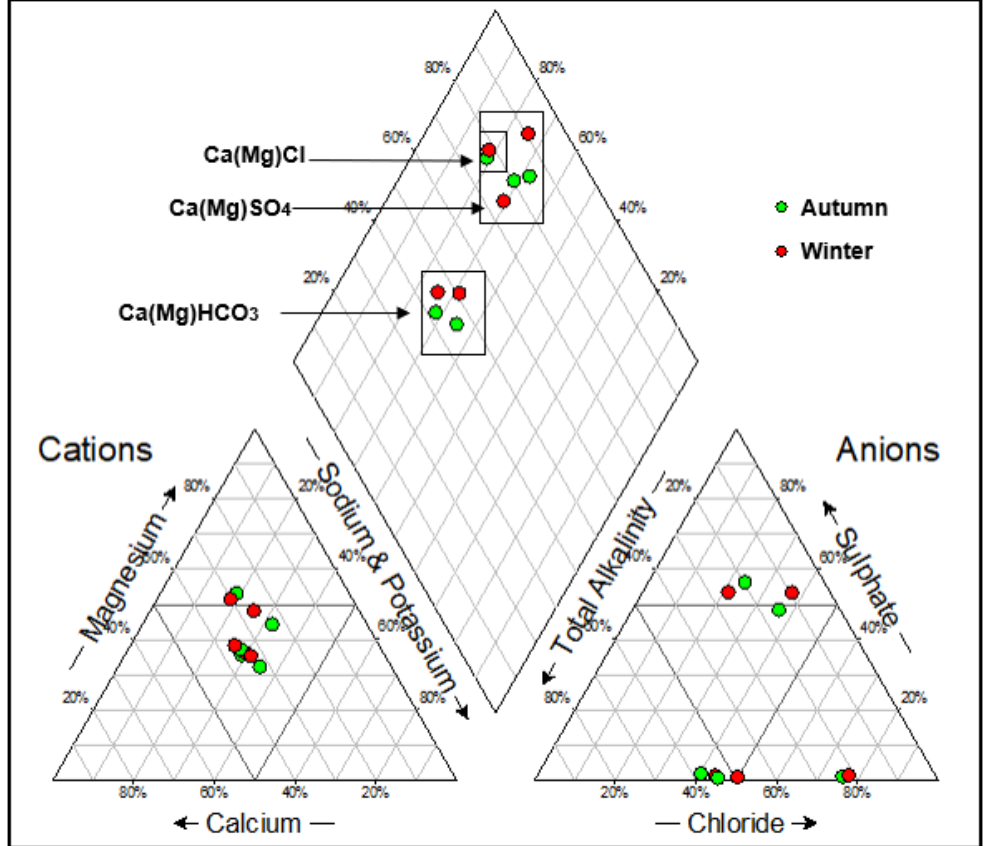
Figure 3. Piper diagram for the groundwater samples in the northern landfill site for the two seasons.